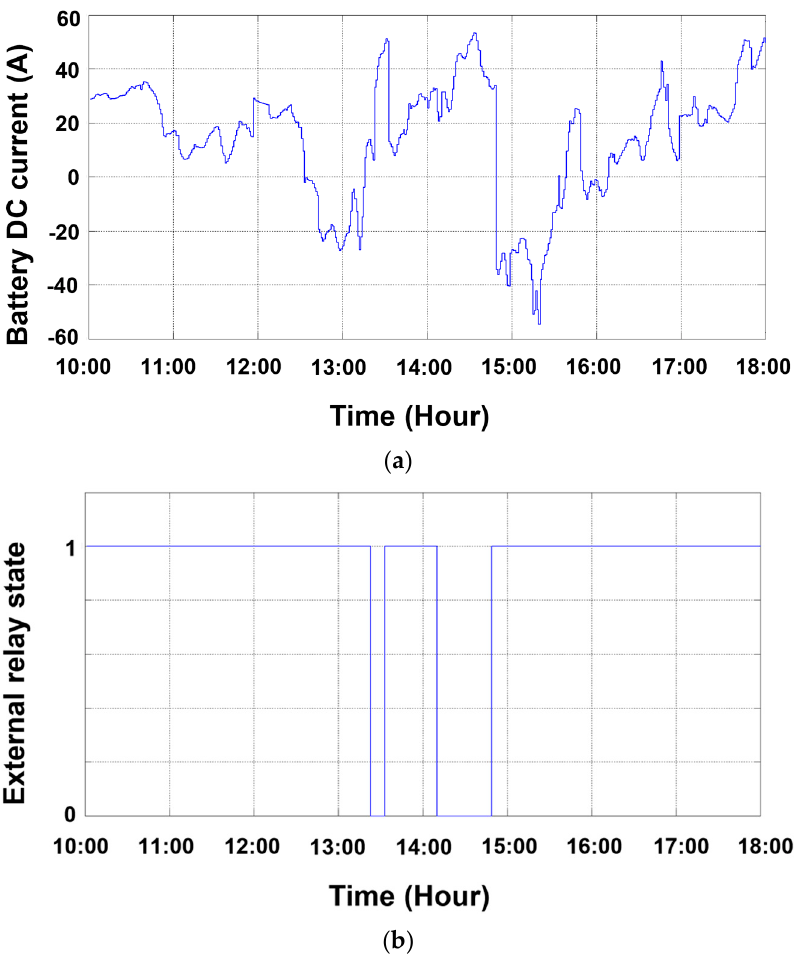
Figure 13. Fuzzy-based EMS in cloudy day: ( a ) ESS DC current and ( b ) grid relay.